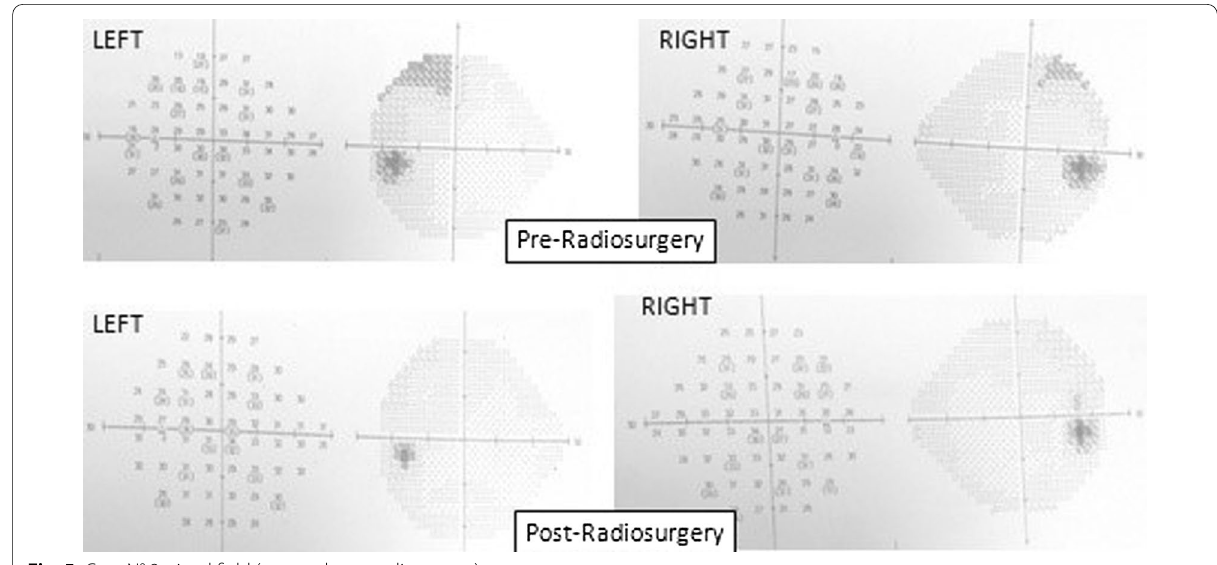
Fig. 5 Case N° 2: visual field (pre- and post-radiosurgery)